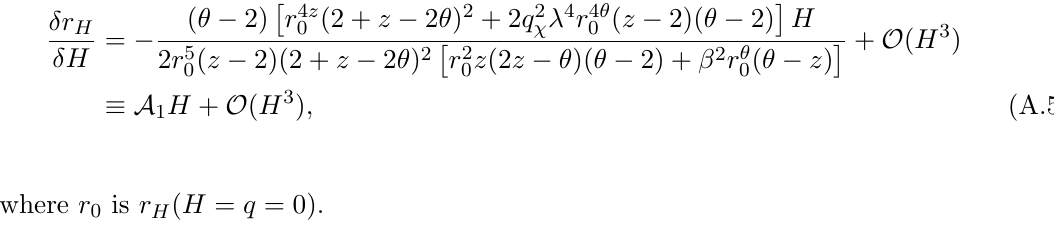
whose exponent is again negative when (cid:18) > 2 z . Therefore, in the region C , D , (cid:27) 0 with temperature regardless of sign of (cid:18) (cid:0) 2 z . This explains the temperature dependence of (cid:27) 0 in (cid:12)gure 6(i) and (j). There is the special case when ( z; (cid:18) ) lies on the boundary of xx NEC, 2 z (cid:0) 2 (cid:0) (cid:18) = 0, where (cid:27) 0 = 1 is independent of T by (A.1), explaining (cid:12)gure 6(a), xx (b), (k) and